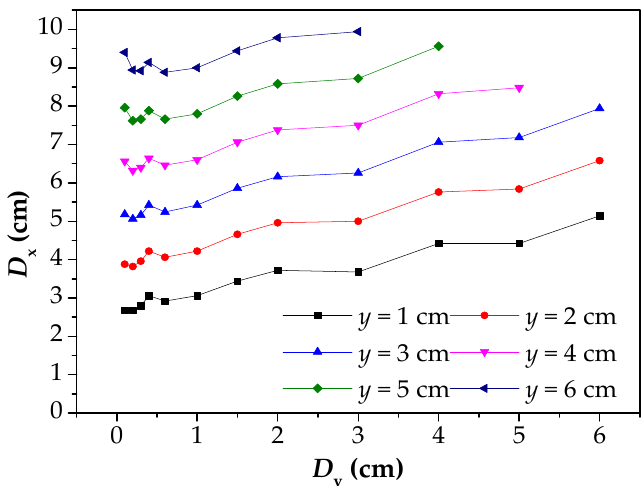
Figure 12. The relationship between D x and D y under different y . D x : the intersecting point distance between curves of magnetic flux component of x direction at different lift off heights; D y : the difference between two lift off heights; y : the lift off height.